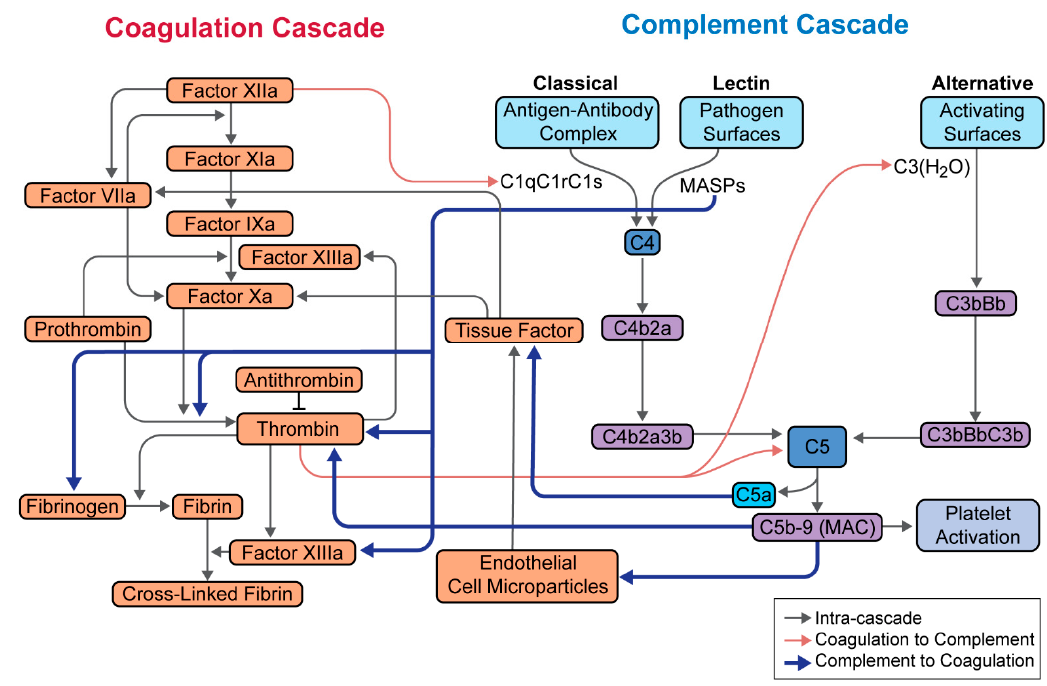
Figure 2. Integration between the complement and coagulation cascades. Relationship between the complement and coagulation cascades, as well as platelet activation is highlighted. Most notable are the effects of MASPs on thrombin, factor XIIIa, and fibrinogen; C5a on tissue factor; and C5b-9 on thrombin. Adapted from Hill et al. [23].